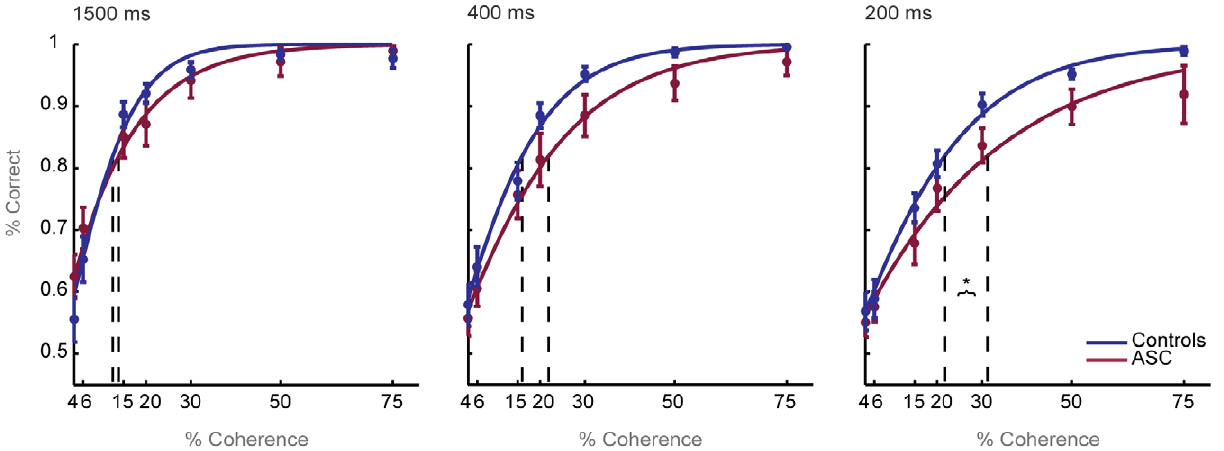
Figure 4. Performance across levels of coherence is offset in ASC at short viewing durations. Average percent correct at each coherence level ( + / 2 1 standard error) is plotted along side a Weibull curve that is fit to group average performance (for illustrative purposes) for the three viewing durations. Dashed lines mark each group’s 82% correct coherent motion perception thresholds. At short viewing durations, the ASC group produces significantly accurate responses across coherence levels.